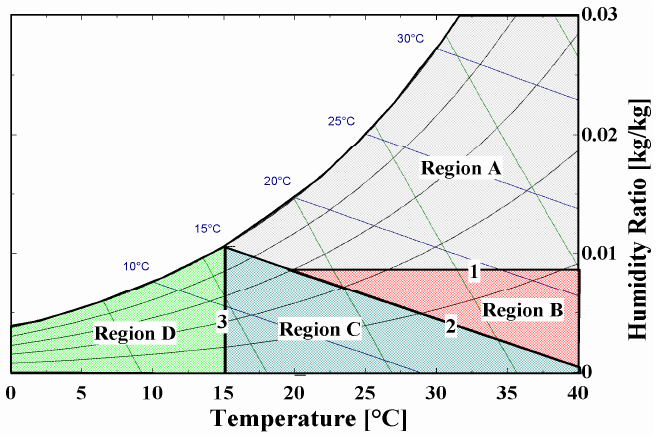
Figure 2. Four regions on the psychrometric chart. Table 1. Operation mode and relevant components